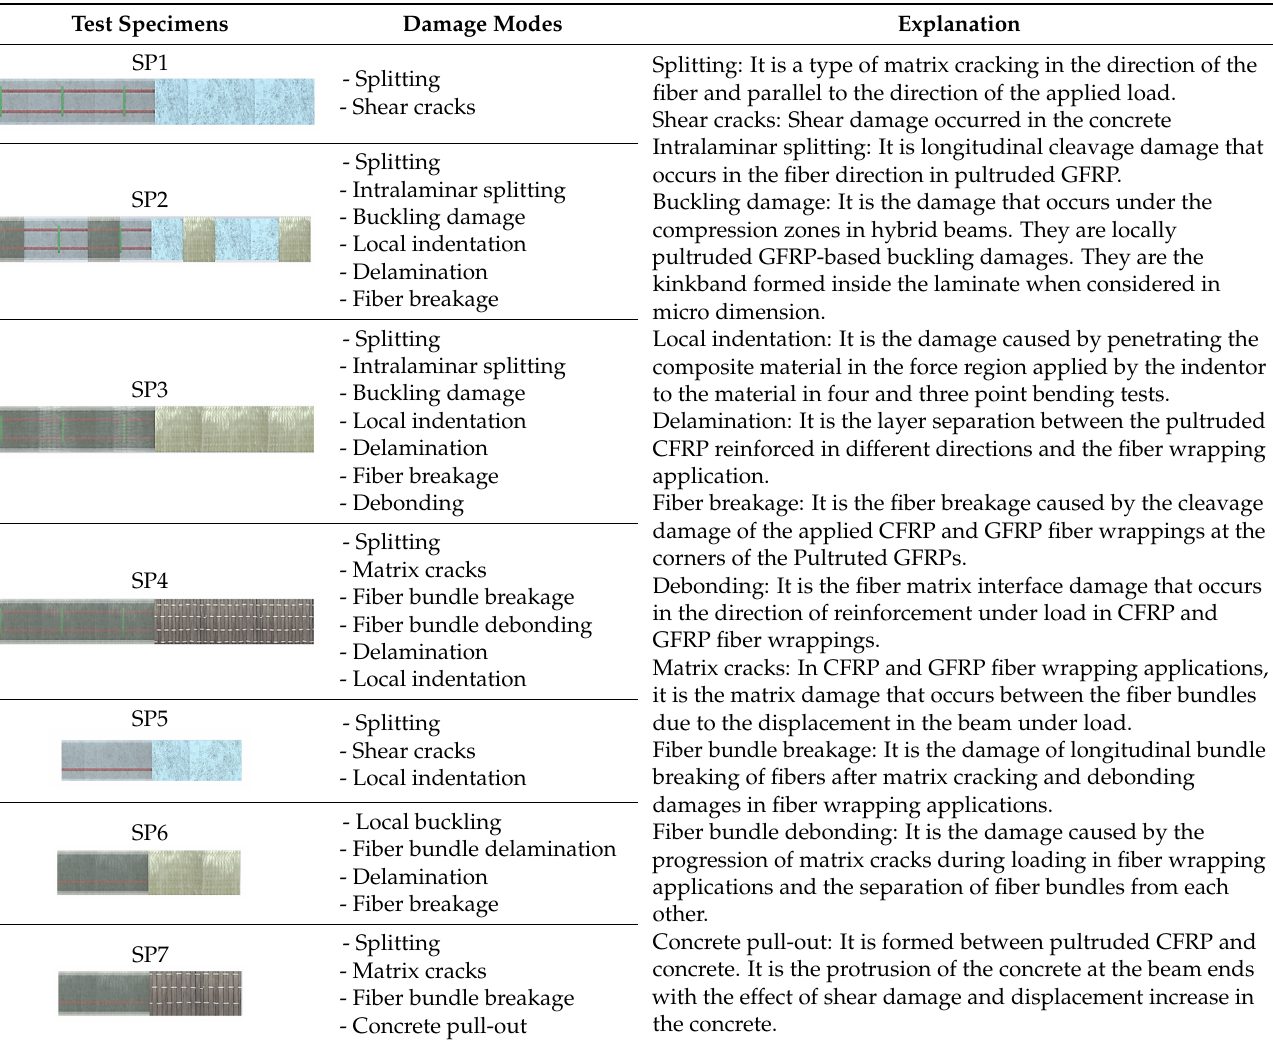
Table 4. Summary of the damages observed in the